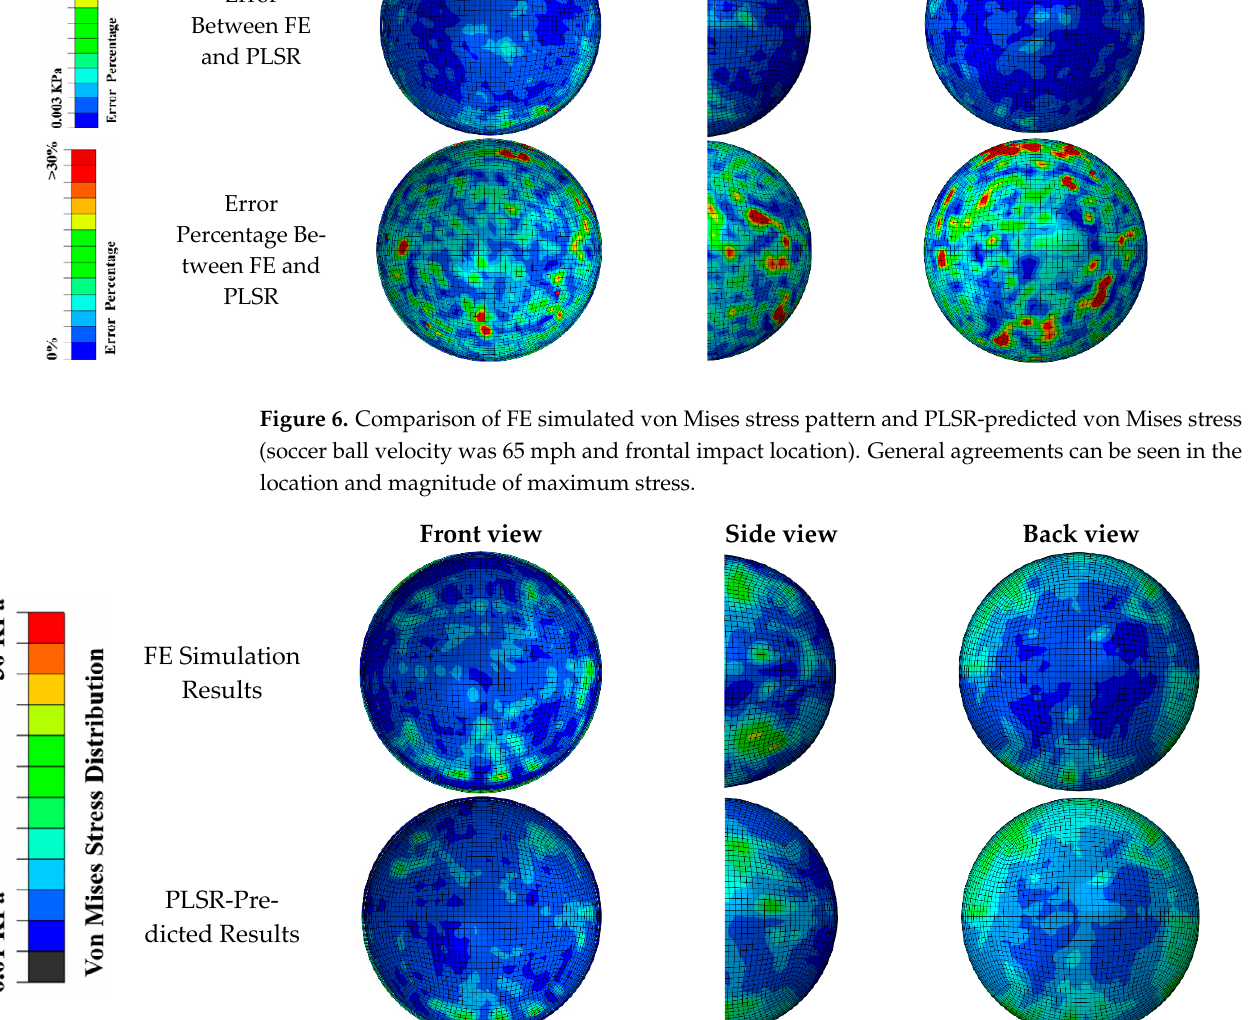
Figure 7. Comparison of FE simulated von Mises stress pattern, and PLSR-predicted von Mises stress (soccer ball velocity was 40 mph and 30-degree angle impact location). General agreements can be seen in the location and magnitude of maximum stress.